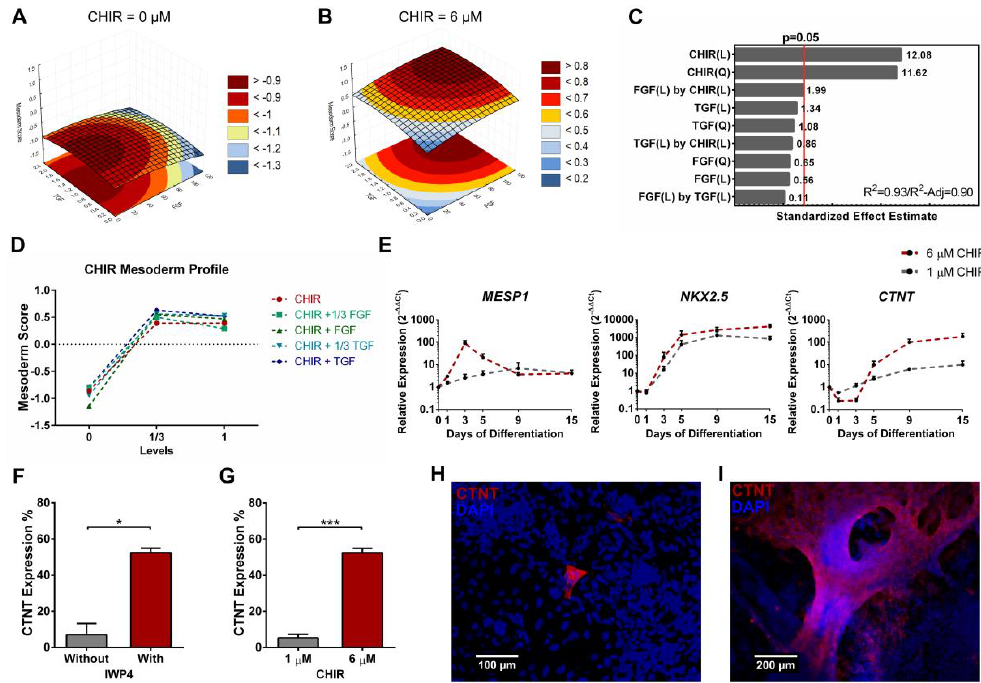
Figure 6. Quadratic model for the mesoderm scores highlighted the contribution of Wnt signaling with higher scores for intermediate CHIR concentrations. ( A , B ) Representative curves of TGF β and FGF2 contributions to the mesoderm model with CHIR set at zero ( A ) and at 6 µ M ( B ). ( C ) CHIR quadratic and linear terms significantly contributed to the mesoderm model. A synergy of CHIR with FGF can also be observed. Model showed a good fit to the data set with a R 2 of 0.93 and a R 2 -Adjusted of 0.90. ( D ) CHIR mesoderm profile shows an increase in mesoderm score at 1 / 3 activation, while higher concentrations maintain or slightly decrease mesoderm scores. ( E ) Real-time PCR comparison of cardiac differentiation using 6 µ M or 1 µ M of CHIR registered a higher gene expression of MESP1 , with a peak at day 3, NKX2.5 and CTNT when 6 µ M is used. Error bars, SEM, n = 3. ( F ) Flow cytometry of cardiac differentiation with or without IWP4 showed that inhibiting Wnt signaling at day 3 is essential to efficiently obtain CTNT positive cells. Error bars, SEM, n = 3. * p -value < 0.05 (two-sided t -test). ( G ) Flow cytometry comparing Wnt signaling low or high activation levels showed that initial low activation originated few CTNT positive cells compared to 6 µ M of CHIR. Error bars, SEM, n = 3. *** p -value < 0.001 (two-sided t -test). ( H , I ) Consistent with flow cytometry, immunostaining showed that 1 µ M of CHIR (H, scale bar 100 µ m) originated few cardiomyocytes while 6 µ M originated cardiomyocytes throughout the culture (I, scale bar 200 µm). See Figures S5 and Table S5 for